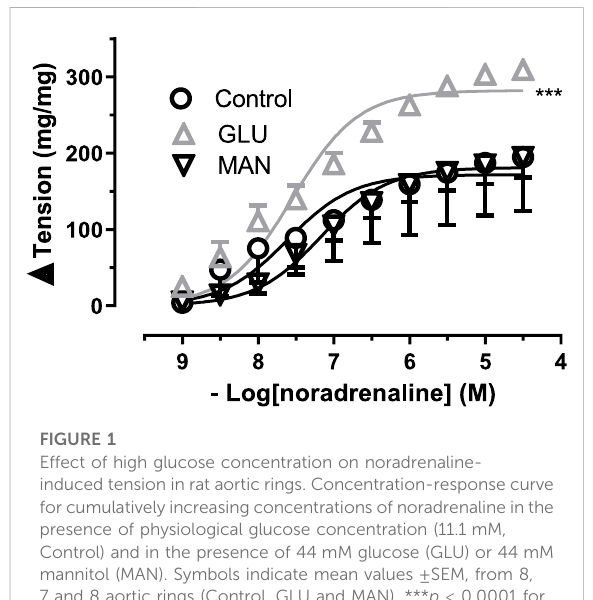
FIGURE 1 Effect of high glucose concentration on noradrenaline- induced tension in rat aortic rings. Concentration-response curve for cumulatively increasing concentrations of noradrenaline in the presence of physiological glucose concentration (11.1 mM, Control) and in the presence of 44 mM glucose (GLU) or 44 mM mannitol (MAN). Symbols indicate mean values ±SEM, from 8, 7 and 8 aortic rings (Control, GLU and MAN). *** p < 0.0001 for larger E max in GLU vs. Control (F-test).